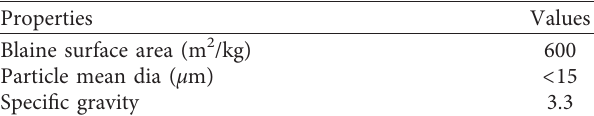
Table 2: Properties of calcined powder (magnesite and steatite).